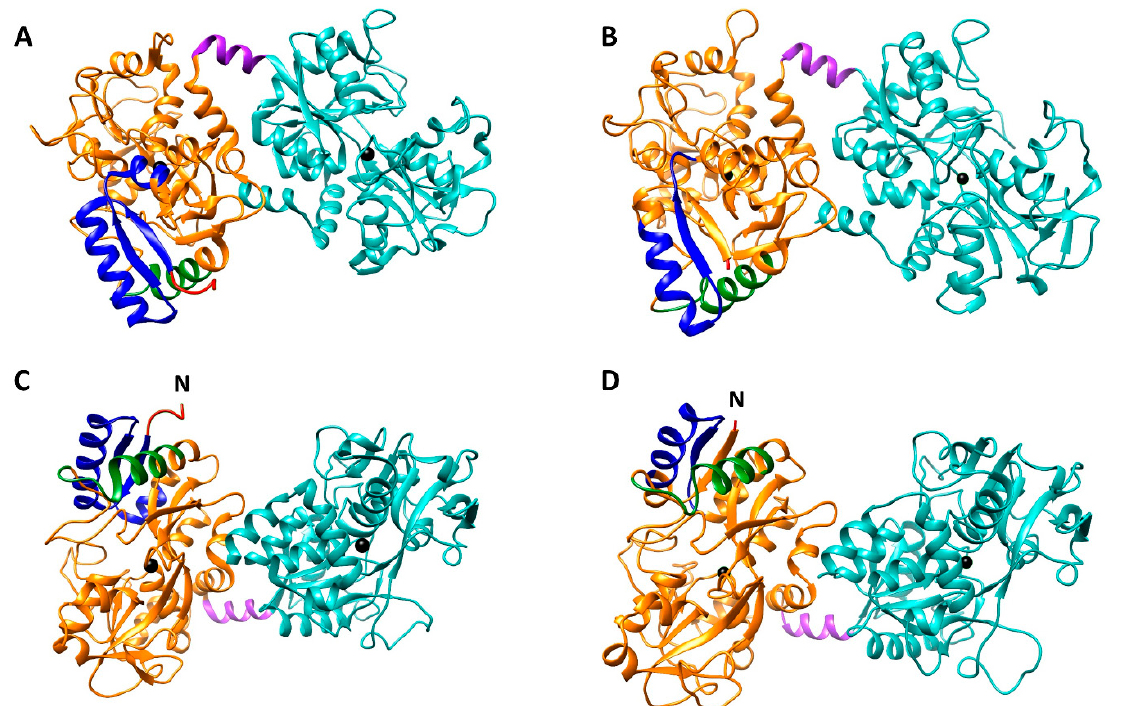
Figure 1. Side ( A , B ) and top ( C , D ) views of the crystal structures of diferric human lactoferrin (hLf) ( A , C ) (PDB code = 1B0L) and bovine lactoferrin (bLf) ( B , D ) (PDB code = 1BLF). The N-lobe is highlighted in orange and the C-lobe in cyan, the connecting α -helix (aa. 334–344 for both glycoproteins) in violet, and the ferric irons are depicted as black spheres. The lactoferricin (aa. 1–47 in hLf and 17–41 in bLf) and lactoferrampin (aa. 269–285 in hLf and 268–284 in bLf) regions are highlighted in blue and green, respectively. N-terminal regions, able to interact with di ff erent glycosaminoglycans on cancer cells, are depicted in red and correspond to the first five amino acids (G 1 RRRR 5 ) for hLf, while in bLf only Asn in position 5 (N 5 ) is shown, as the first four amino acids (A 1 PRK) are absent in the crystal structure. As evident from the top view, the cationic lactoferricin, lactoferrampin and the N-terminal region are packed close to each other and constitute a basic domain able to interact with prokaryotic and eukaryotic cell surface receptors, thus exerting multifaceted activities.